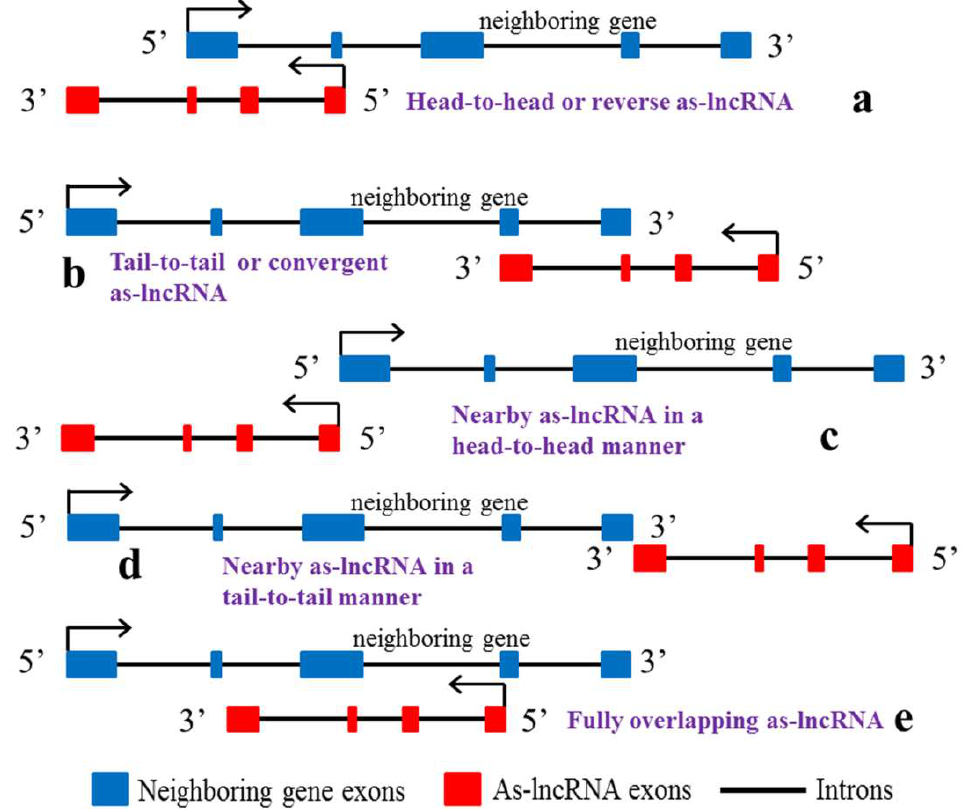
Figure 1. Classification of cis-acting as-lncRNAs. ( a ) Head-to-head as-lncRNAs, neighbouring genes and the 5′ ends of lncRNAs are aligned together. ( b ) Tail-to-tail as-lncRNAs, neighbouring genes are aligned with the 3′ end of lncRNAs. ( c ) Nearby as-lncRNAs in a head-to-head manner, the 5′ end of as-lncRNAs are near the 5′ end of the neighbouring genes. ( d ) Nearby as-lncRNAs in a tail-to-tail manner, the 3′end of as-lncRNAs are near the 3′end of the neighbouring genes. ( e ) Fully overlapping as-lncRNAs, as-lncRNAs completely overlap with neighbouring genes.